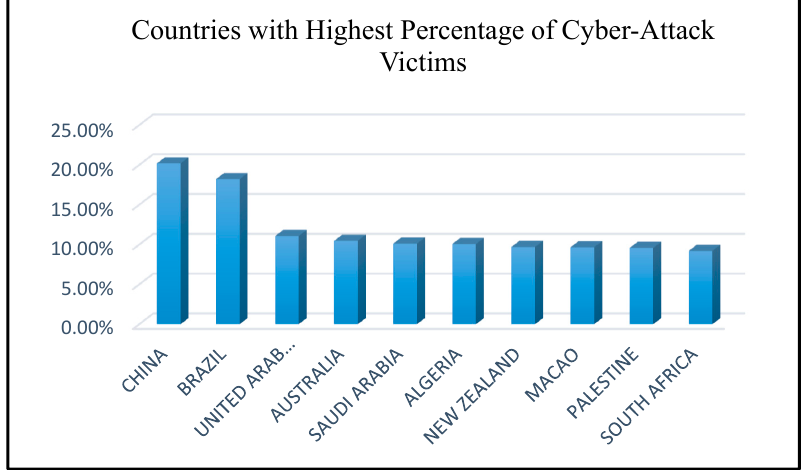
Figure 2. Countries with the highest percentage of cyber-attack victims [1].